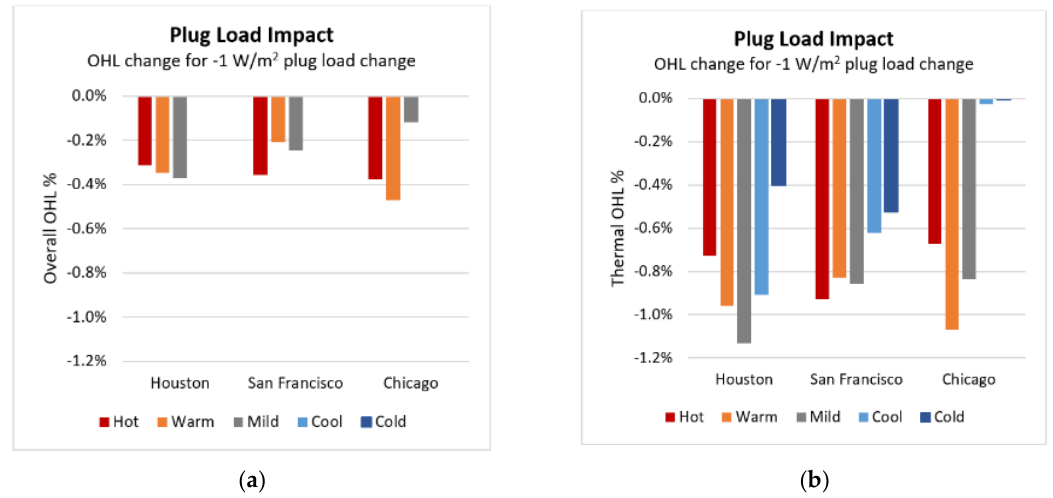
Figure 14. Impact of a 1 W/sq.m decrease in plug loads on overall ( a ) and thermal ( b ) OHL.